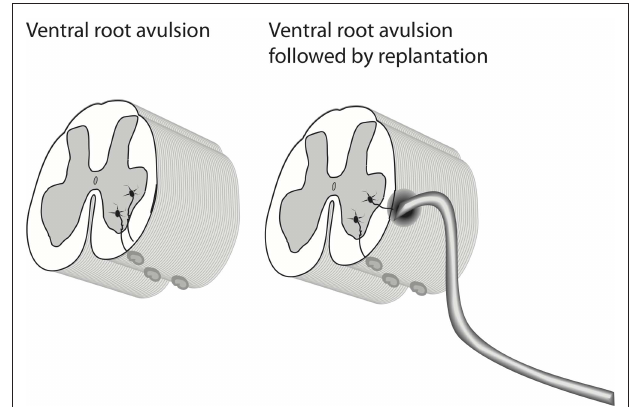
Figure 1 | A schematic representation of the employed experimental